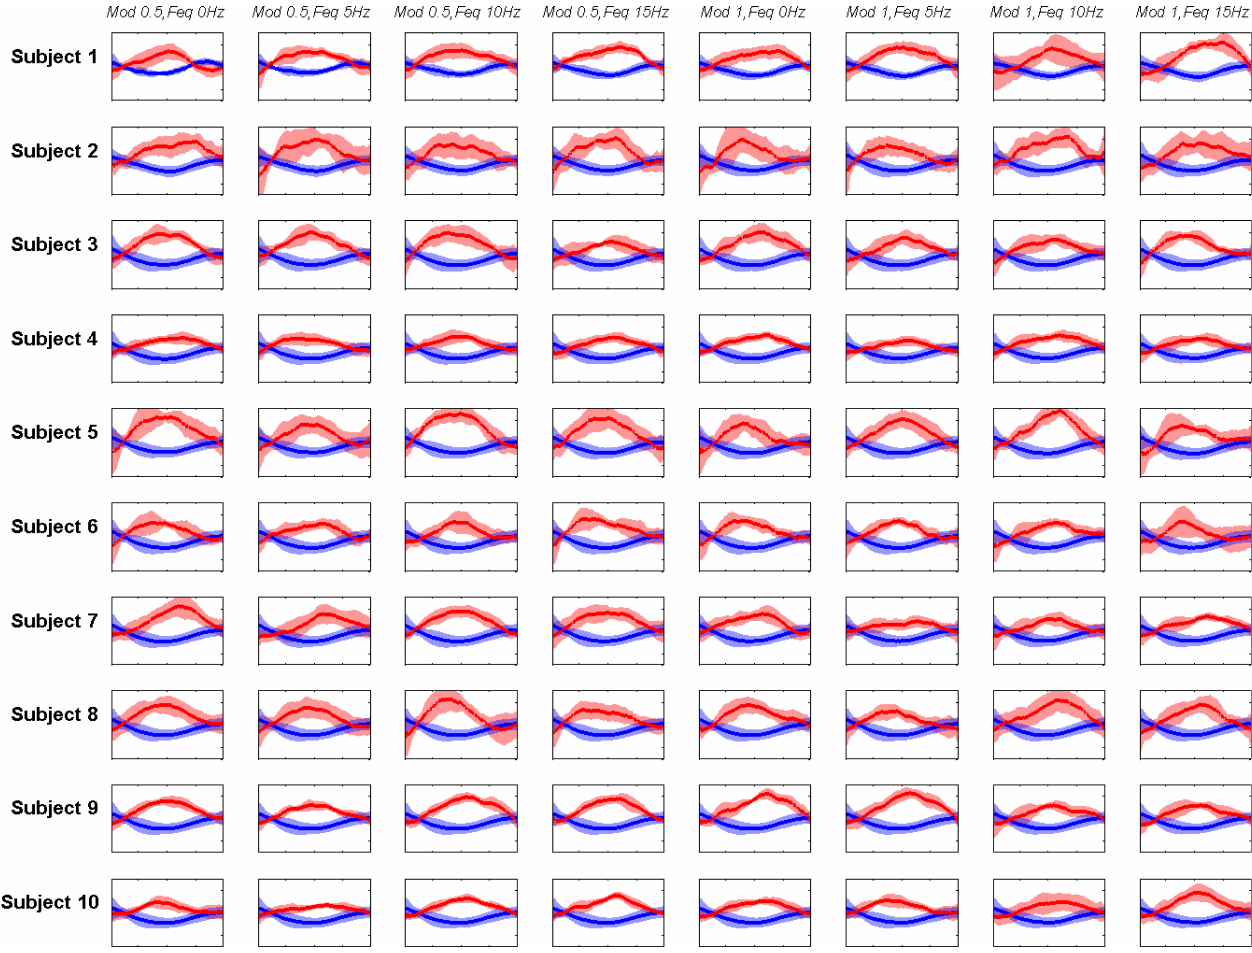
Fig. 8. The folding-average of the oxy-Hb and deoxy-Hb concentration over all frequencies, modulations and subjects. Oxy-Hb curves are in red while deoxy-Hb curves are in